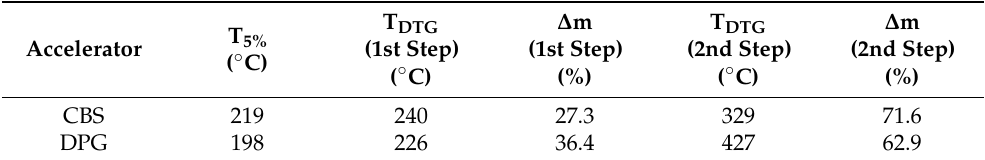
Table 8. Thermal stability of pure CBS and DPG measured by TG (SD: T 5% ± 1 ◦ C; T DTG ± 1 ◦ C; ∆ m ±